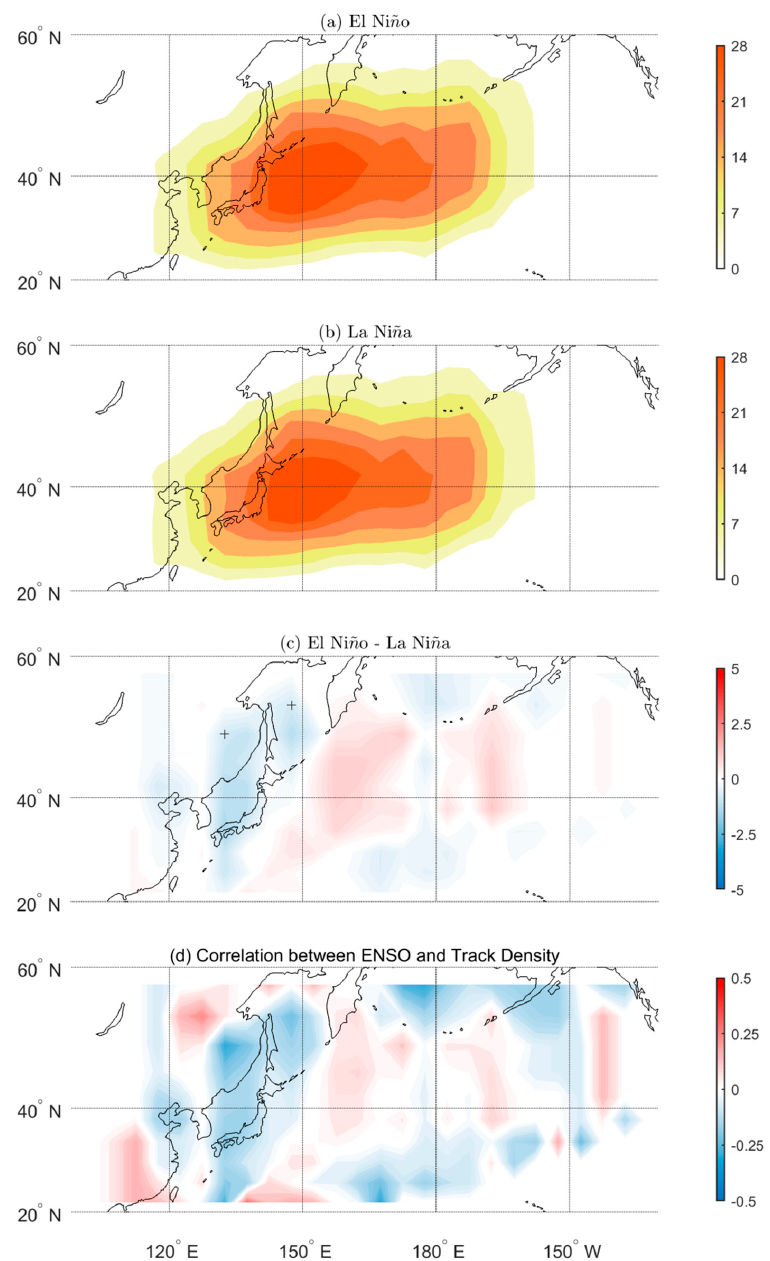
Figure 3. ( a , b ) Composite of ETC track density in El Niño and La Niña years over the Northwest Pacific in wintertime from 1979 to 2018, Unit: cyclones per winter per grid. ( c ) The difference in ETC density between the El Niño and La Niña years. ( d ) Correlations between ENSO index and ETC track density. Grids with values statistically significant at the 95% level are indicated by the symbol “+”.